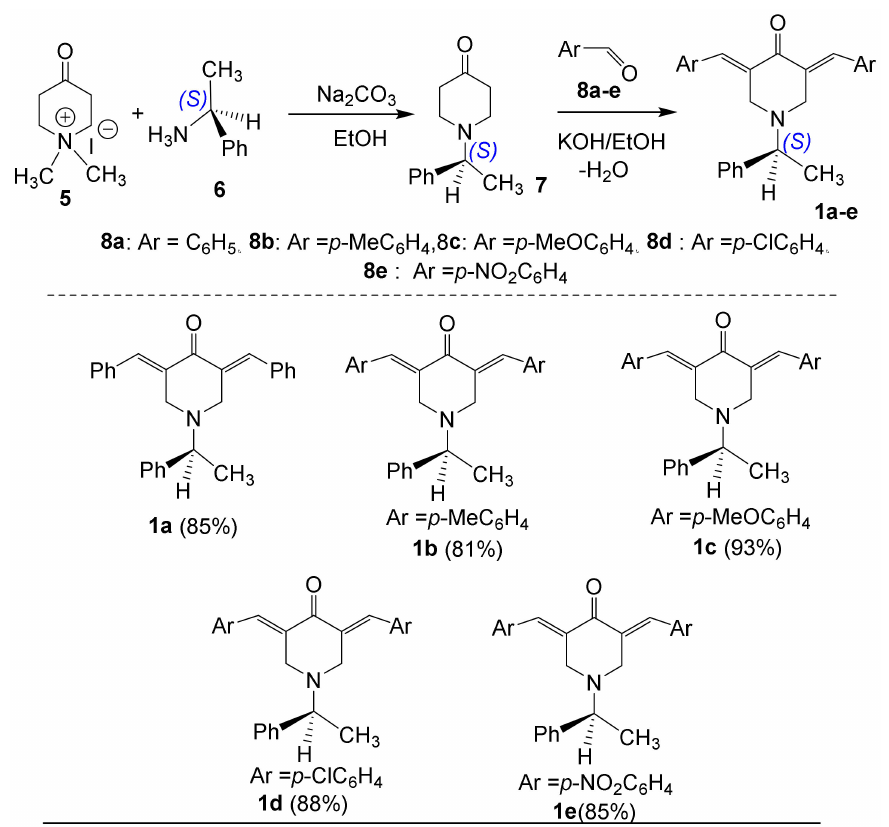
Scheme 2. Synthetic route to (S)- (-) -( 1-methylbenzyl)-3,5 -(E,E)- bisarylidene-4-piperidones 1a – e .